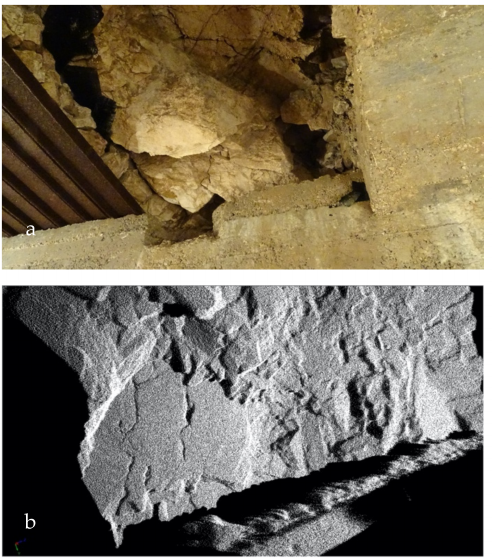
Figure 17. Images of collapsing zones: ( a ) picture of collapsing niche 3, ( b ) point clouds of collapsing niche 3.